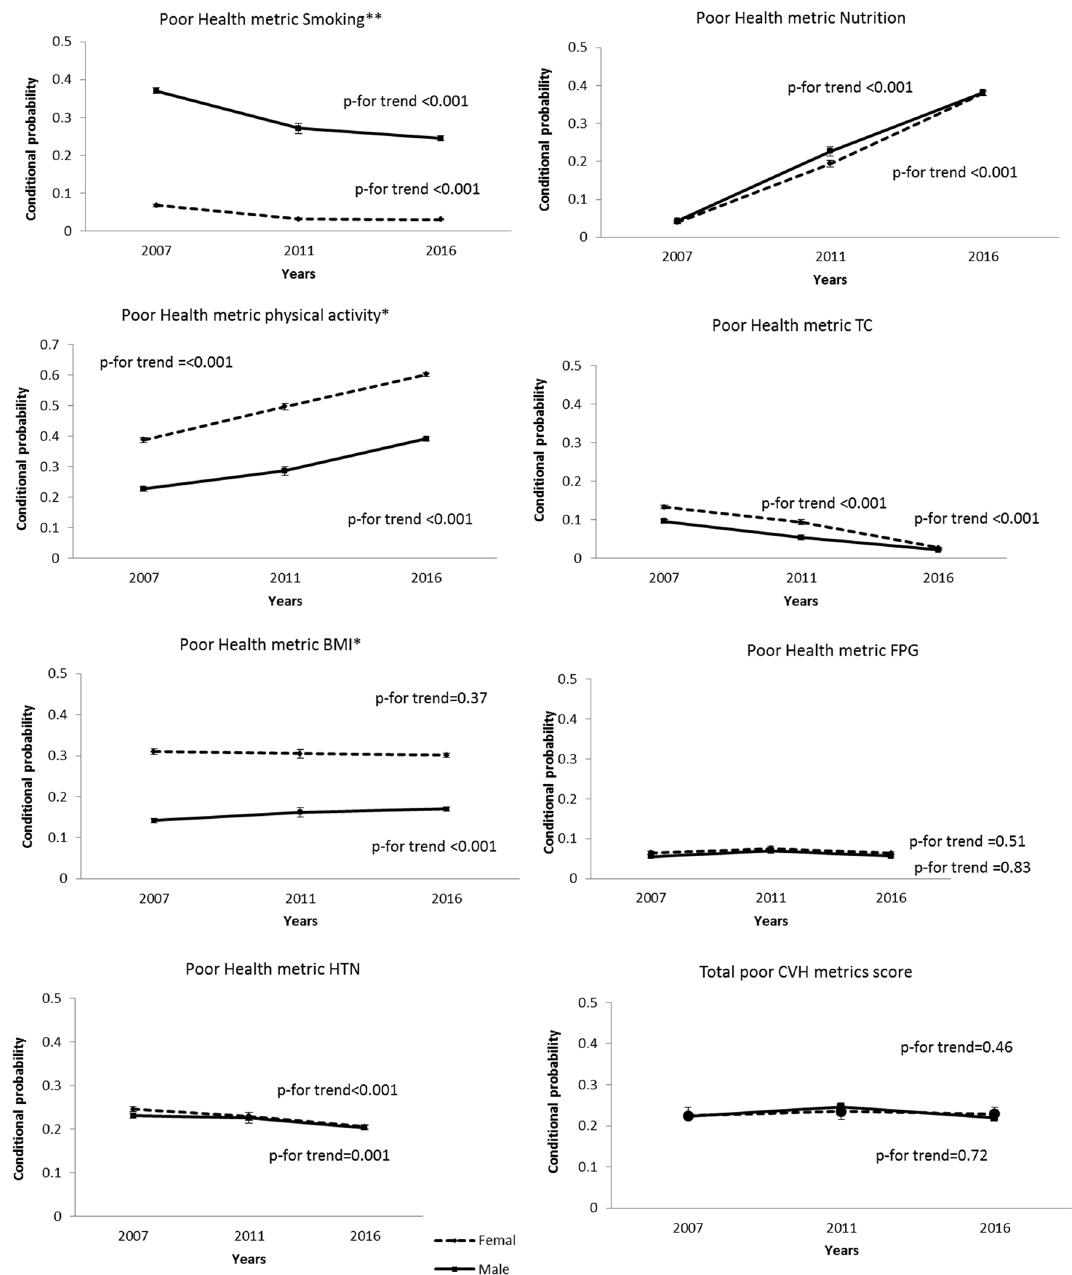
Figure 2. Conditional probability and trend of seven poor health metrics compared to ideal and intermediate categories as a reference among men and women. **0.0001 < p value ≤ 0.001; *0.001 < p value ≤ 0.05. TC, total cholesterol; BMI, body mass index; FPG, fasting plasma glucose; HTN, hypertension; CVH, cardiovascular